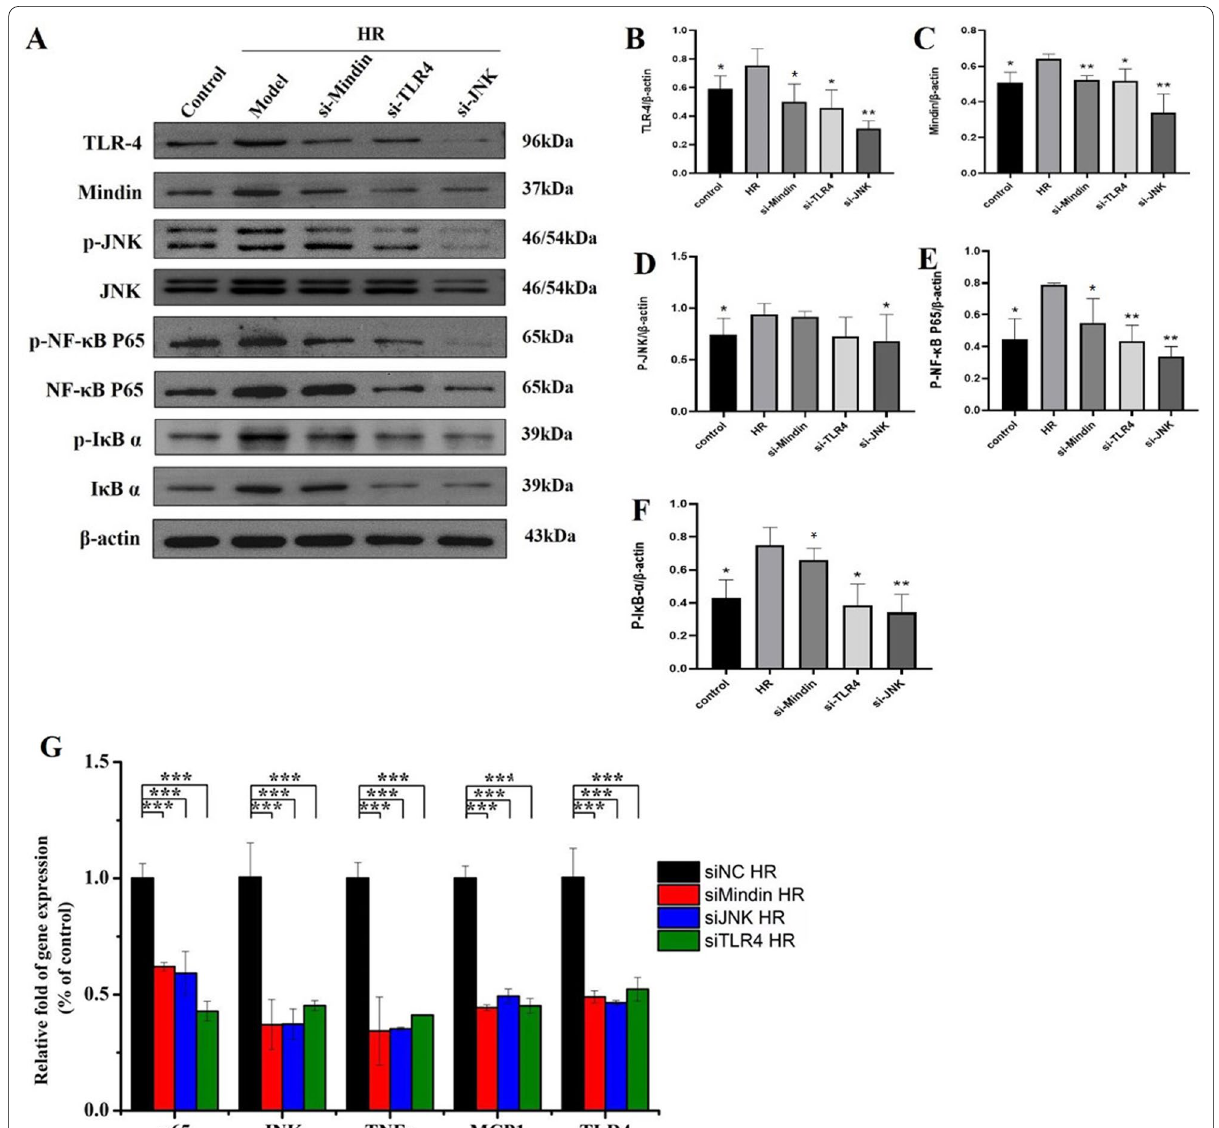
Fig. 6 Mindin knockdown inhibited the activation of TLR4/JNK/ NF-κB signaling after HR in vitro. A TLR4, Mindin, phosphorylated JNK, phosphorylated P65, and phosphorylated IκBα measured by western blot analysis in si-Mindin, si-TLR4 and si-JNK cells induced by HR respectively. B – F Quantitative analysis of TLR4, Mindin, phosphorylated JNK, phosphorylated P65, and phosphorylated IκBα protein expression. * P < 0.05, ** P < 0.01 versus HR. G Quantitative analysis of TLR4, JNK, P65, TNF-α and MCP-1 mRNA expression in si-Mindin, si-TLR4 and si-JNK cells induced by HR respectively. ***P < 0.001 versus control HR